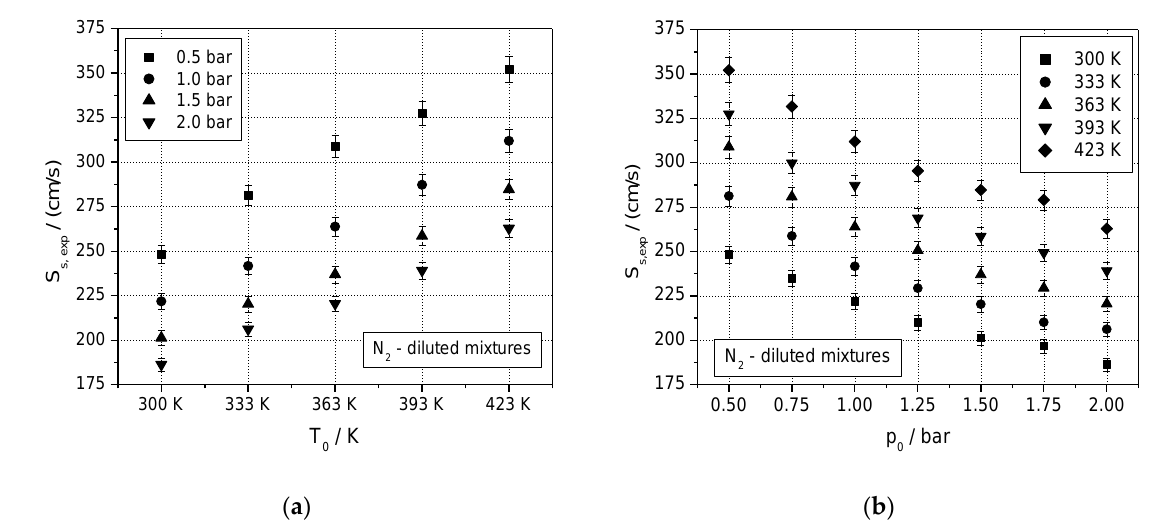
Figure 3. Experimental PVs of stoichiometric C 3 H 8 -air diluted with 10% N 2 : ( a ) S s versus the initial temperature at various initial pressures; ( b ) S s versus the initial pressure at various initial temperatures.